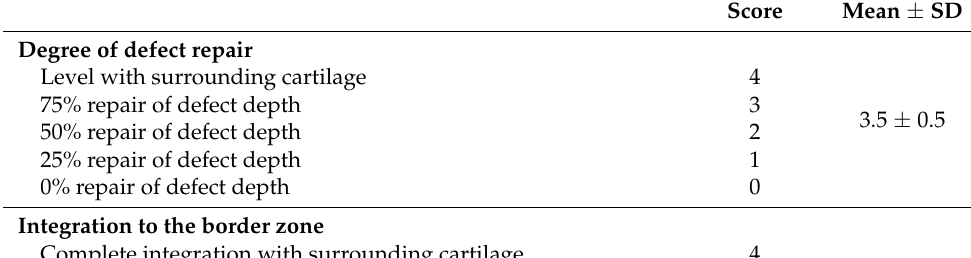
Table 2. Cartilage repair assessment of second arthroscopic findings.